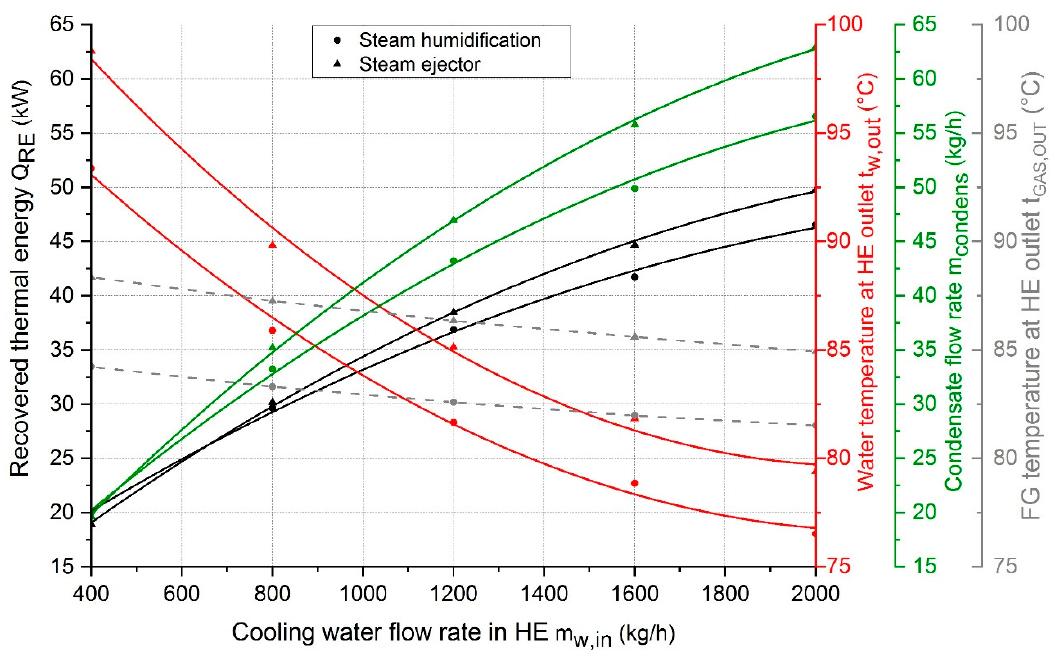
Figure 8. Comparison between the results calculated for concepts 2 and 4. Influence of the cooling water flow rate in the HE on the recovered thermal energy (black lines), the water temperature at the HE outlet (red lines), the condensate flow rate (green lines) and the flue gas temperature at the HE outlet (gray lines).